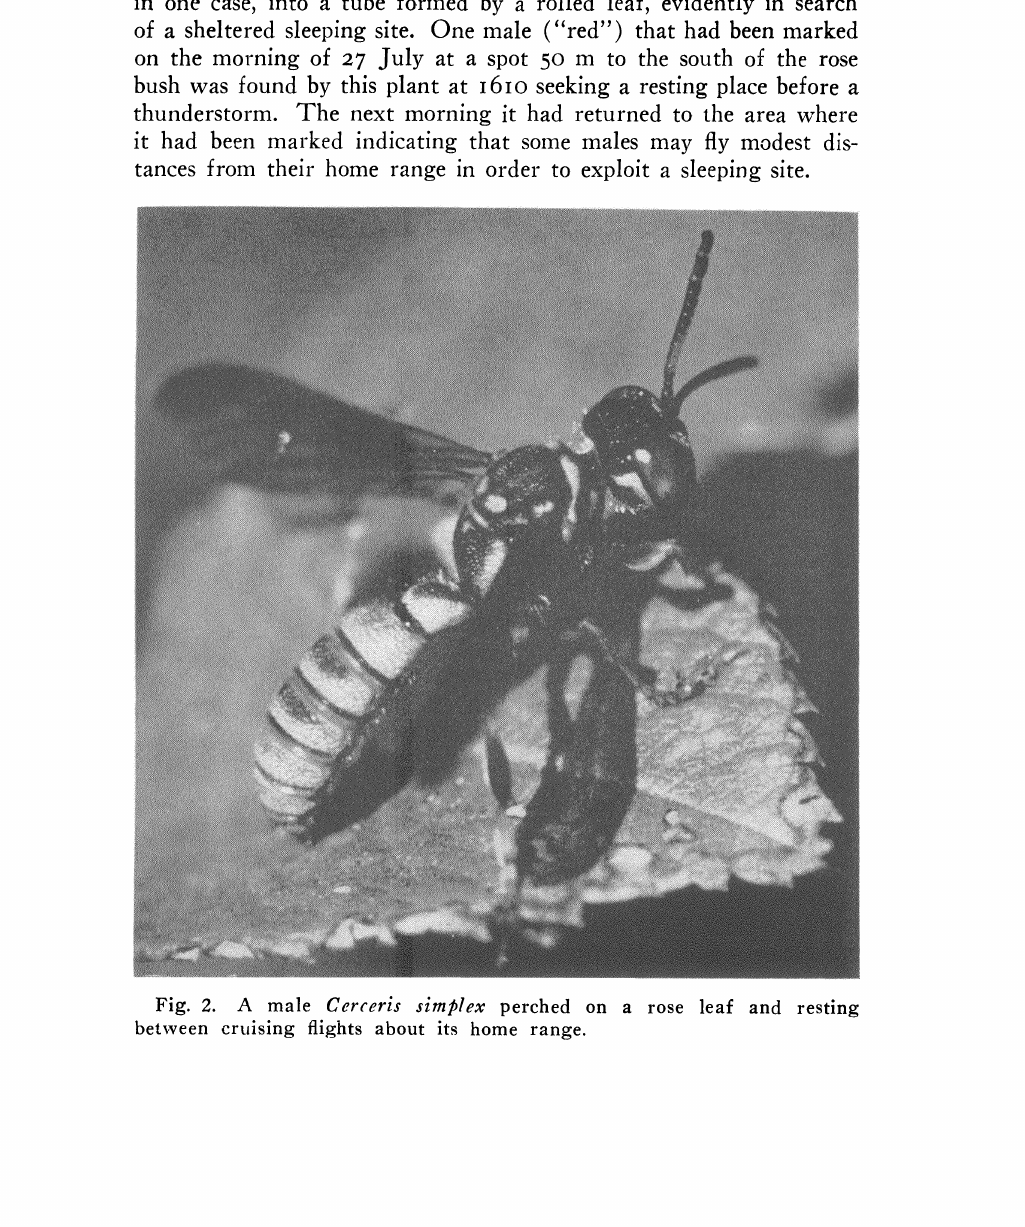
Fig. 2. A male Cerceris simplex perched on a rose leaf and resting between cruising flights about its home